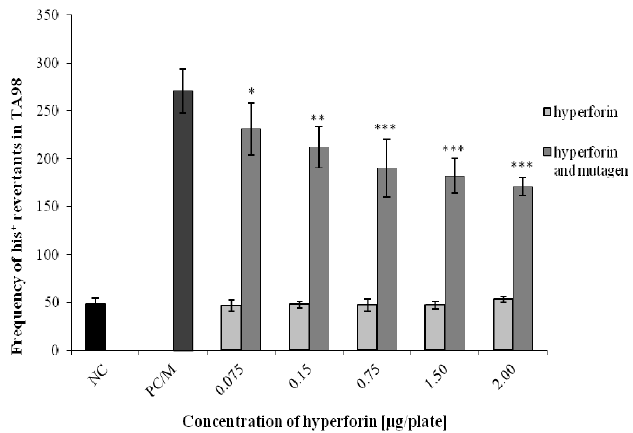
Figure 4. Determination of HF antimutagenic effects using the Ames test—strain S. typhimurium TA98. Data shown are mean ±SD of three repeated experiments. NC = negative control; PC/M = positive control = mutagen = (4-nitroquinoline-1-oxide). Comparison with positive control (PC): * 0.01 < p < 0.05; ** 0.001 < p < 0.01; *** p < 0.001.